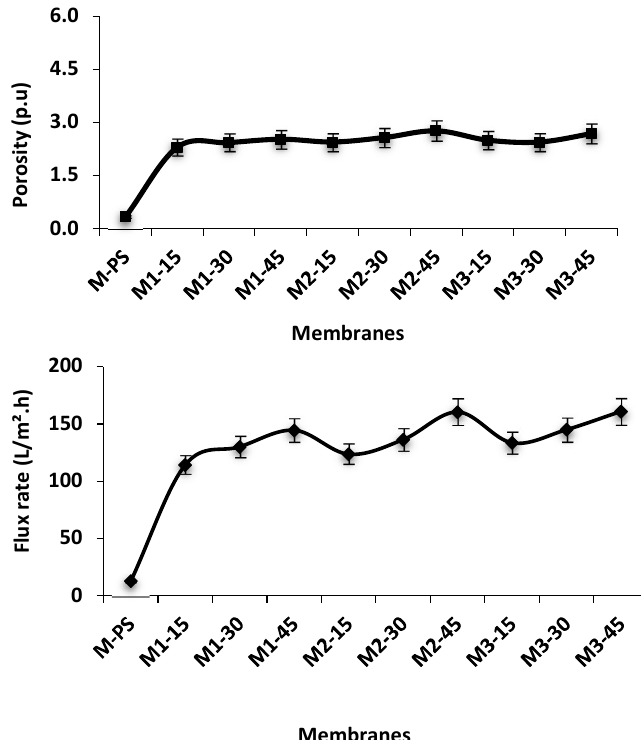
Figure 10. Pure water flux rate and porosity of all formulated membranes ( n = 3).